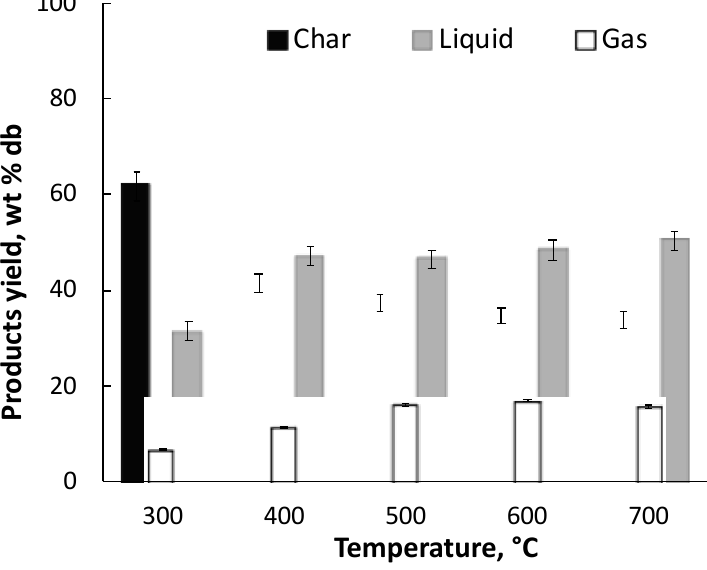
Figure 3. Yields of pyrolysis products of lignin rich residue (LRR), at different temperatures.